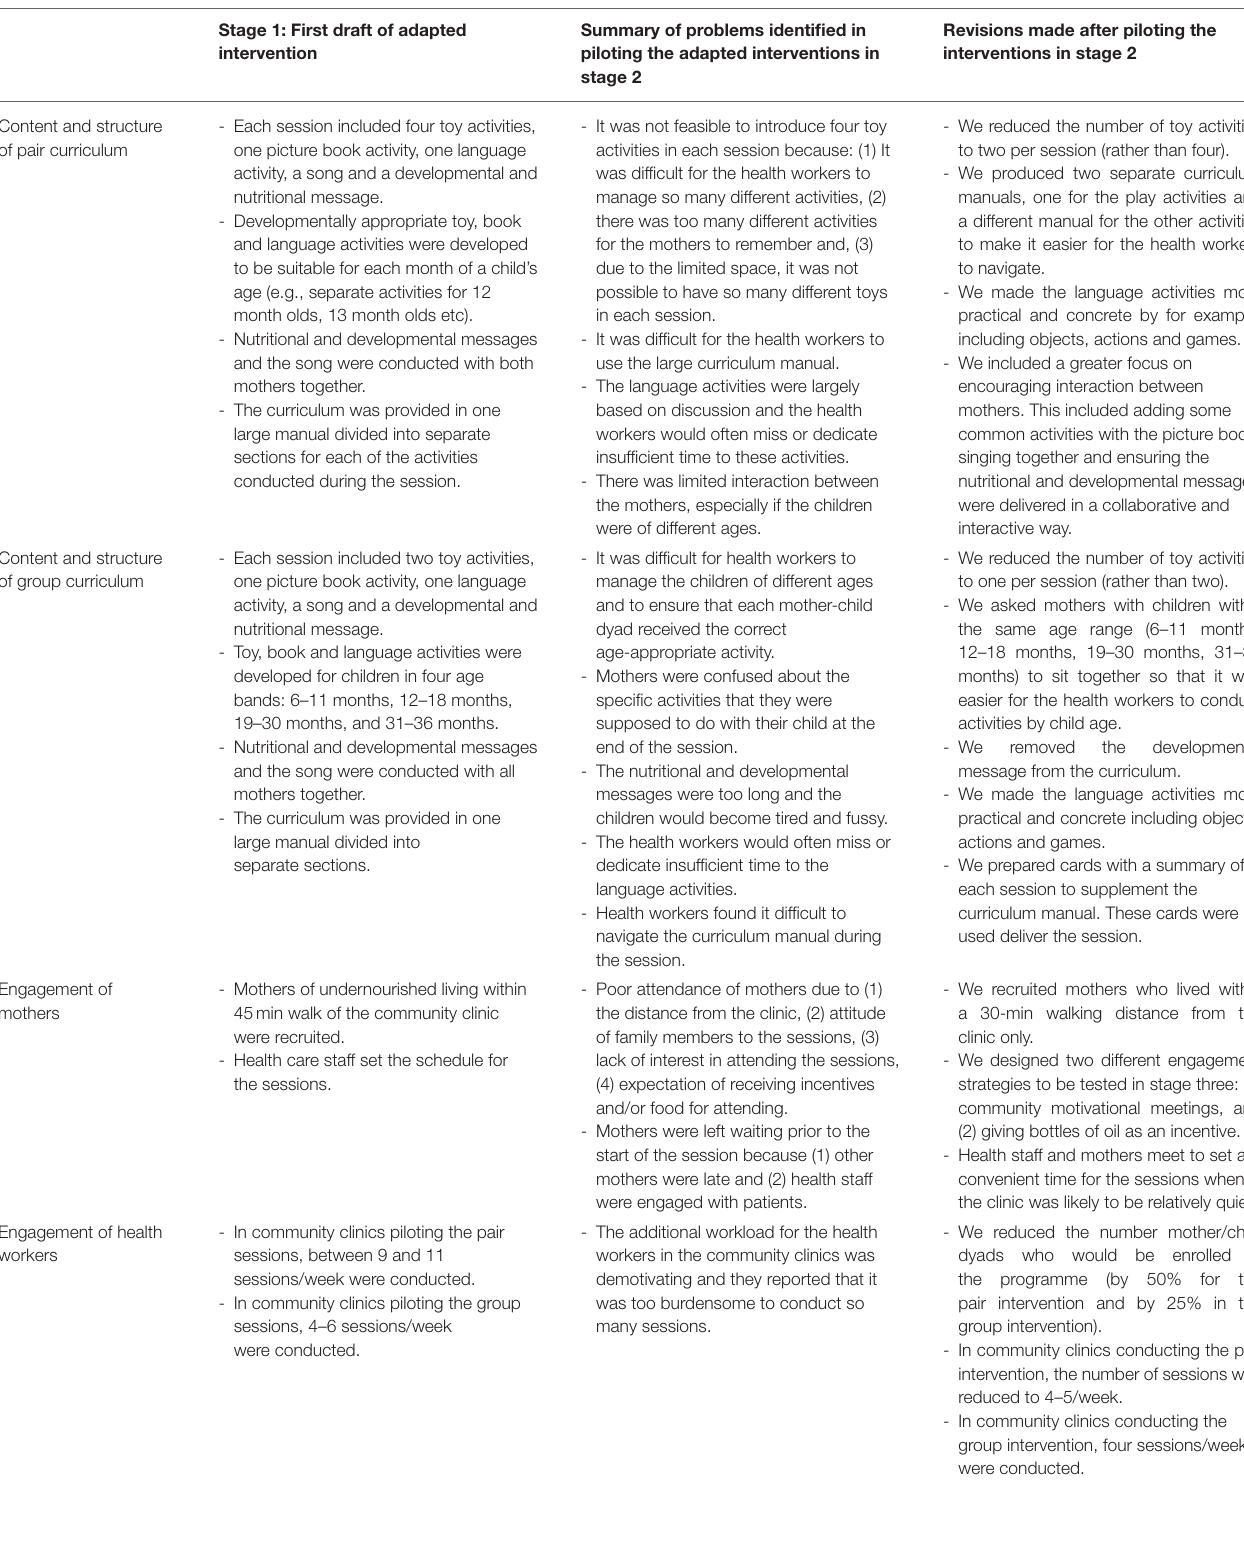
TABLE 1 | Development of the pair and group curricula.